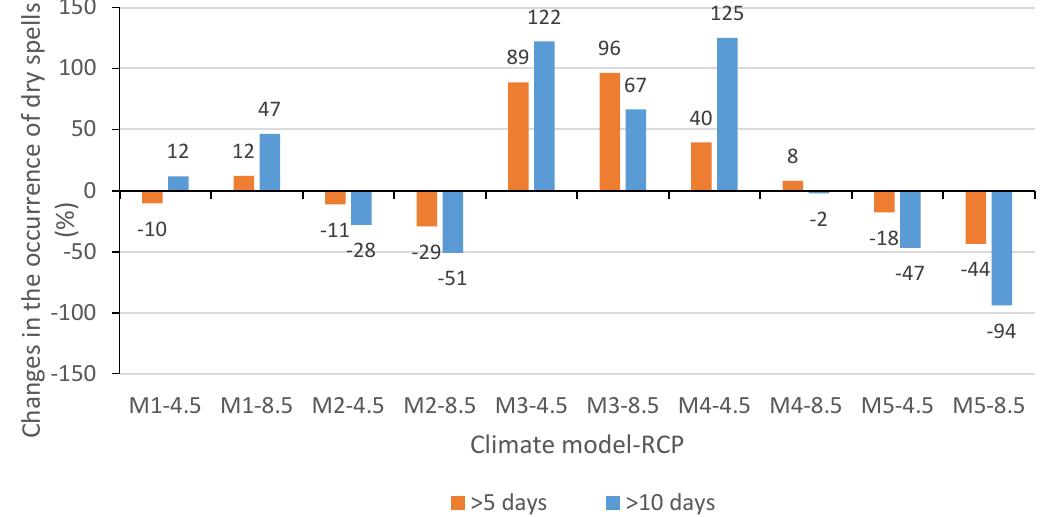
Figure 9. Relative changes of >5 day and >10 day dry spells of the predicted period (from 2021 to 2030) compared to the reference period (from 1971 to 2000): M1 : CCLM-CNRM; M2 : CCLM-EARTH; M3 : CCLM-ESM; M4 : HIRHAM-NorESM; and M5 : RACMO-EARTH. Bias-corrected data were utilized. The threshold of a rainy day was set 0.1 mm. The analysis was performed in the rainy season (from June to October).